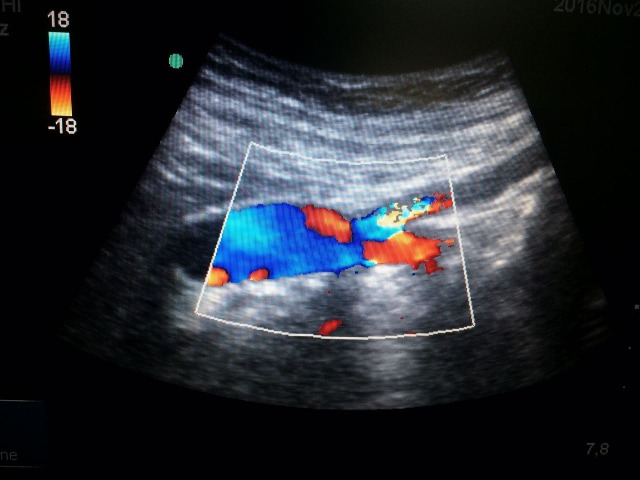
Longitudinal ultrasonography with Doppler for postoperative control, conducted 6 months after the procedure, showing the graft patent, with no stenosis, dilatations, or pseudoaneurysm formation.